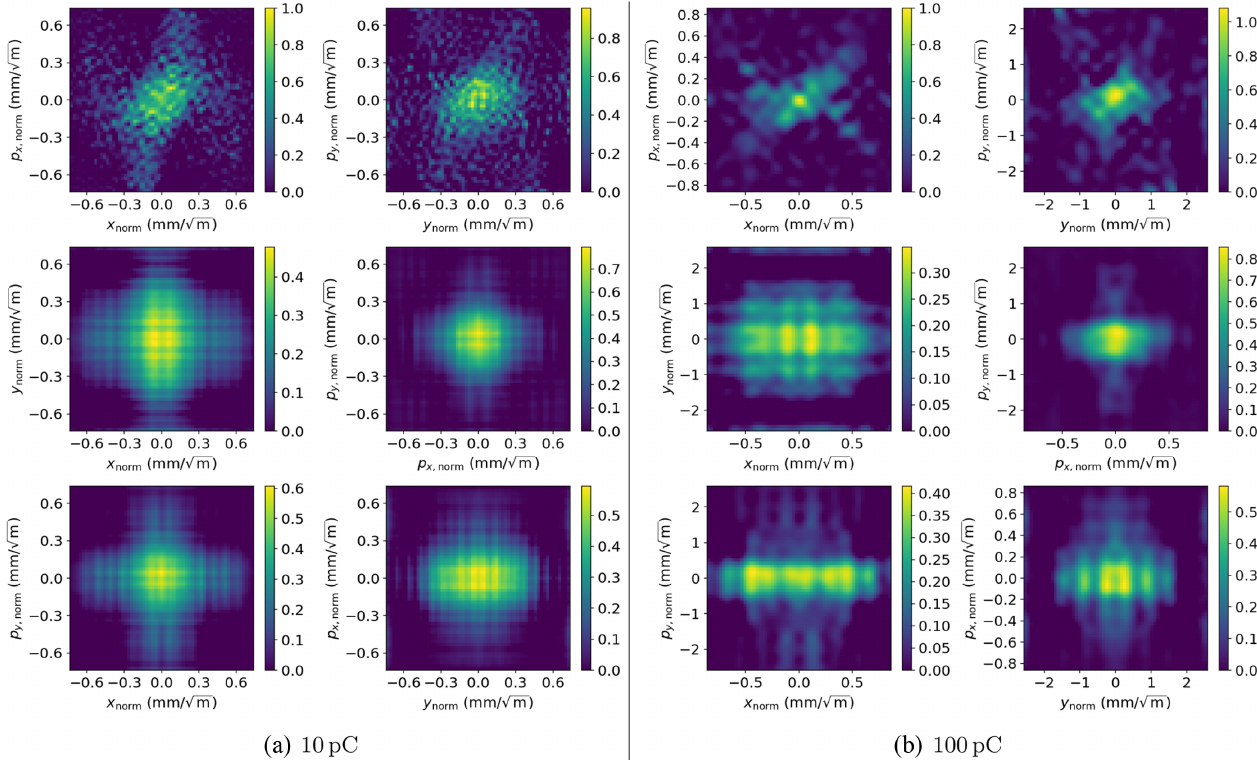
FIG. 3. Projections of the 4D phase space distribution of the beam in CLARA at the exit of the linac, for (a) 10-pC bunch charge and (b) 100-pC bunch charge, found from algebraic reconstruction